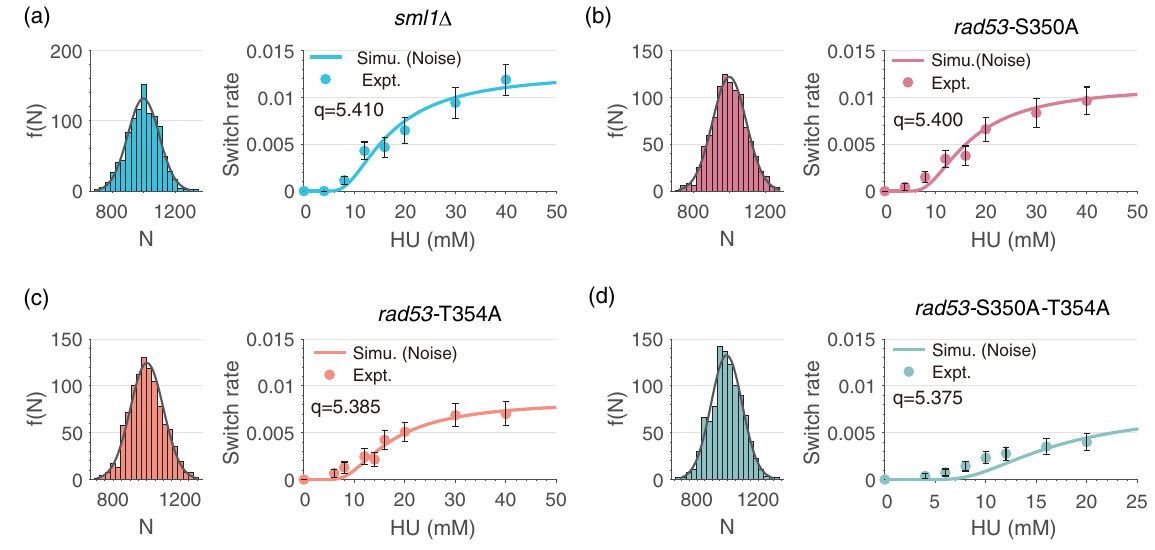
FIG. 13. Switch rate of sml 1 Δ (a), rad 53 -S 350 A (b), rad 53 -T 354 A (c), and rad 53 -S 350 A-T 354 A (d) strains after considering the extrinsic noise. The left panel of each subfigure denotes the distribution of N values (number of all Rad53 molecules) in our simulations, which obeys a Gaussian distribution with a standard deviation of 100. The right panel of each subfigure denotes the corresponding switch rate. The switch rate of the WT strain is similar to the sml 1 Δ strain, as shown in the Supplemental Material